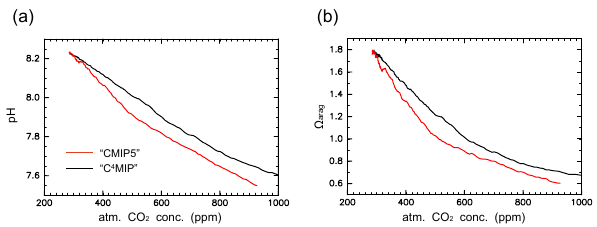
Fig. 5. Change in modified annual mean of (a) pH and (b) (cid:127) arag with atmospheric CO 2 concentration in the Arctic surface waters for “C 4 MIP” (black) and “CMIP5” (red) model